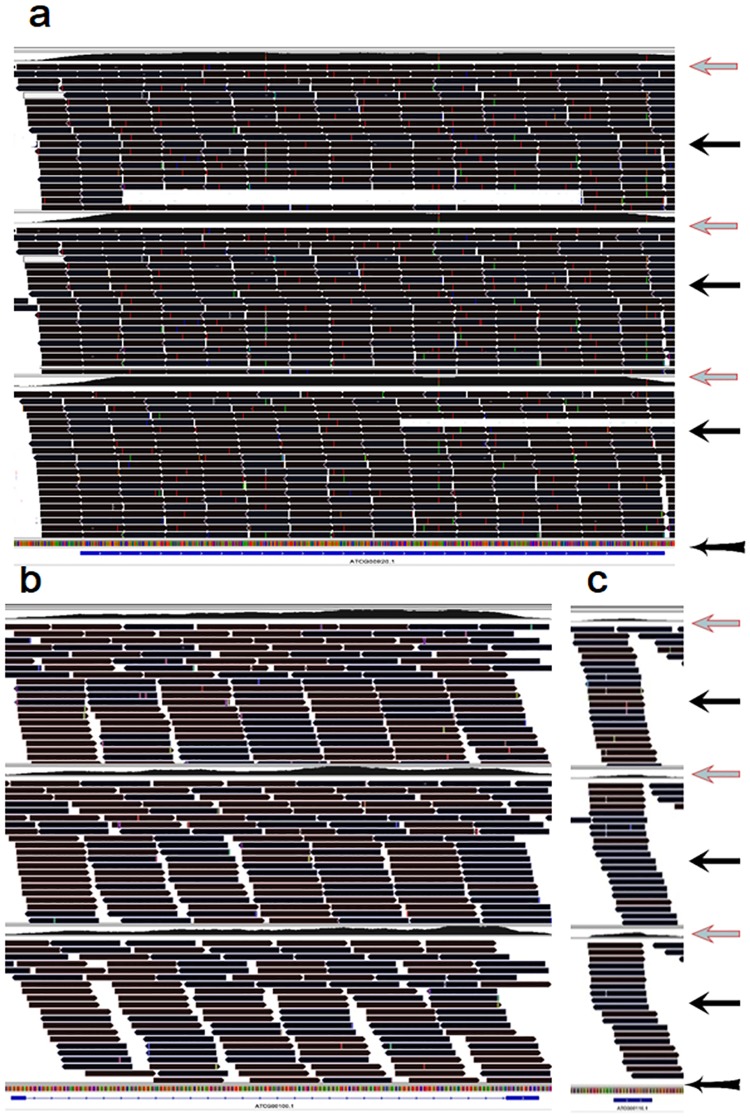
Screenshots from the IGV visualized program present m6A topologies in rRNA and tRNAs in the Arabidopsis chloroplast/amyloplast.Extent of m6A methylation, sequencing depth, sequencing fragment alignment, and gene ID of the sequencing data can be clearly visualized by the IGV program [42]. The area in the screenshot indicated by the arrow, “Red leftwards arrow”, presents m6A methylation extent across the transcript. The area in the screenshot indicated by the arrow, “Black leftwards arrow”, presents sequencing fragment alignment across the transcript. The area in the screenshot indicated by the arrow, “Black leftwards arrow with tail”, presents gene ID information including gene ID, sequence reading direction, the intron and exon regions. (a) The whole rRNA was highly methylated by m6A, representative rRNA, ‘ATCG00920’; (b) The whole tRNA with intron was highly methylated, representative tRNA, ‘ATCG00100’; and (c) The whole tRNA without intron was highly methylated, representative tRNA, ‘ATCG00110’. The Trace files of three organs, leaves (the upper), flowers (in the middle) and roots (the lower) were presented within a screenshot.